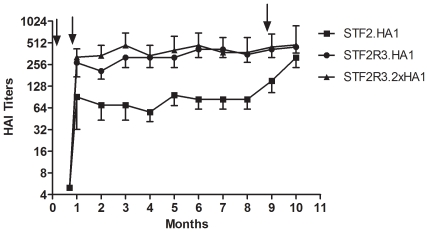
Longevity of neutralizing antibody response.Mice (n = 5) were immunized s.c. with the indicated candidates (1 µg/mouse), and bled monthly for 10 months. Serum neutralizing antibody titers were measured by HAI assay and expressed as GMTs +95%CI. Immunization time points (days 0, 21 and 266) are given in arrows.